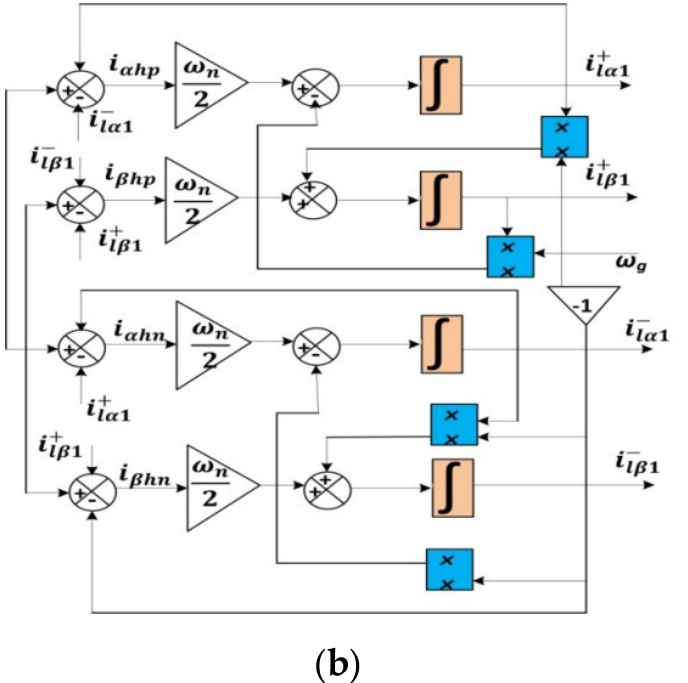
Figure 2. ( a ) Modified complex vector scheme; ( b ) modified complex-vector-filter for HFPS compo- nents extraction.